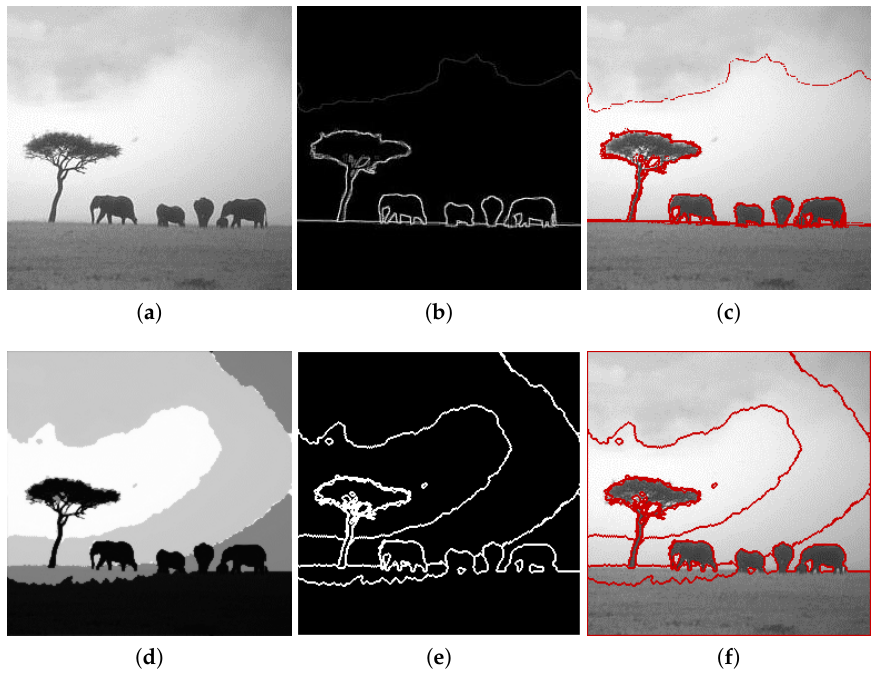
Figure 10. ( a ) Original image (from BSDS500), ( b ) ground truth boundaries obtained by manual segmentation (from BSDS500), ( c ) ground truth boundaries shown on the original, ( d ) the result of the proposed four-class segmentation method, ( e ) boundaries of the regions shown in ( d , f ) boundaries of the segmented regions shown on the original